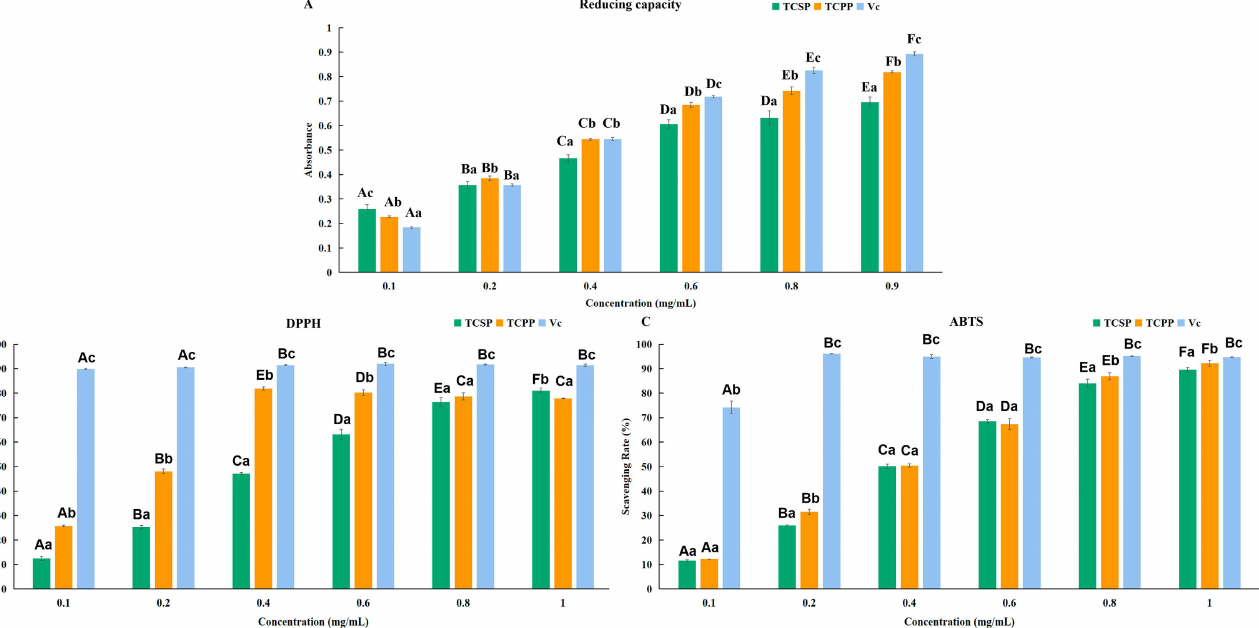
Figure 4. Antioxidant activity of TCPP, TCSP and Vc. Reduction capacity ( A ), Diphenyl picryl hydrazinyl (DPPH) radical scavenging activity ( B ) and 2,2-azino-bis (3-ethylbenzothiazoline–6- sulfonic acid) (ABTS) radical scavenging activity ( C ). Capital letters represent inter-group differences, and lowercase letters represent intra-group differences. TCSP: polysaccharides from stems of Trollius chinensis Bunge; TCPP: polysaccharides from petals of Trollius chinensis